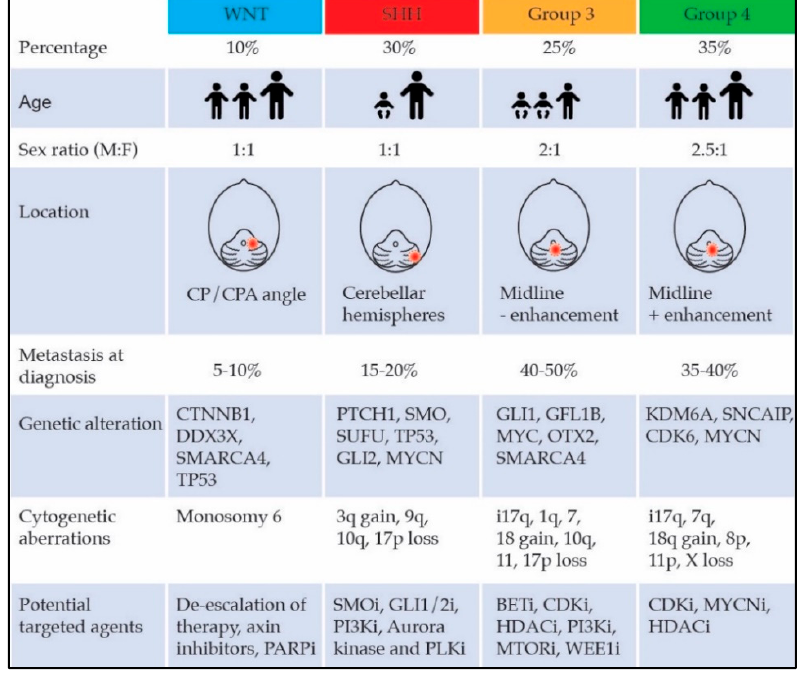
Figure 1. Molecular subgroups of medulloblastoma with unique clinical, genetic, and prognostic characteristics. CP/CPA, cerebellar-pontine/cerebellar-pontine angle; SHH, sonic hedgehog; WNT, wingless and int.